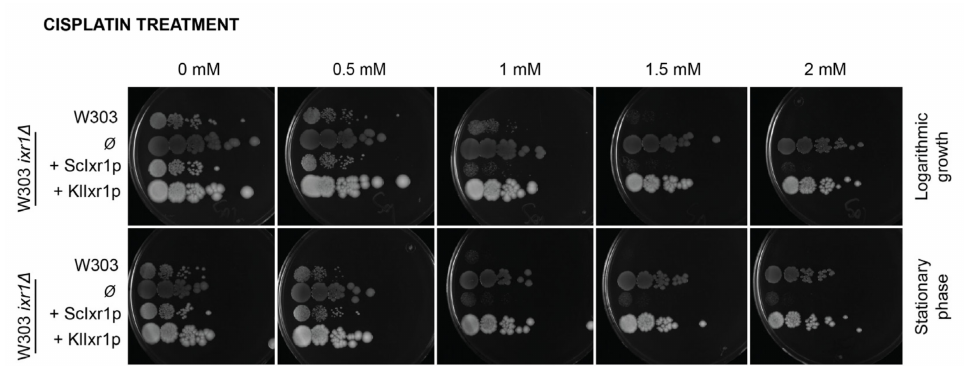
Figure 2. Effect of cisplatin treatment on cell growth (in logarithmic and stationary phase) of strain W303 and derivatives. ixr1 ∆ null strain was transformed with the plasmid pAG426GAL-ccdB, either empty ( Ø ), or containing the IXR1 ORFs from S. cerevisiae or K. lactis under the control of the GAL1 promoter. Serial dilutions of the cells (1, 10 − 1 , 10 − 2 , 10 − 3 , 10 − 4 , 10 − 5 ; from left to right) were